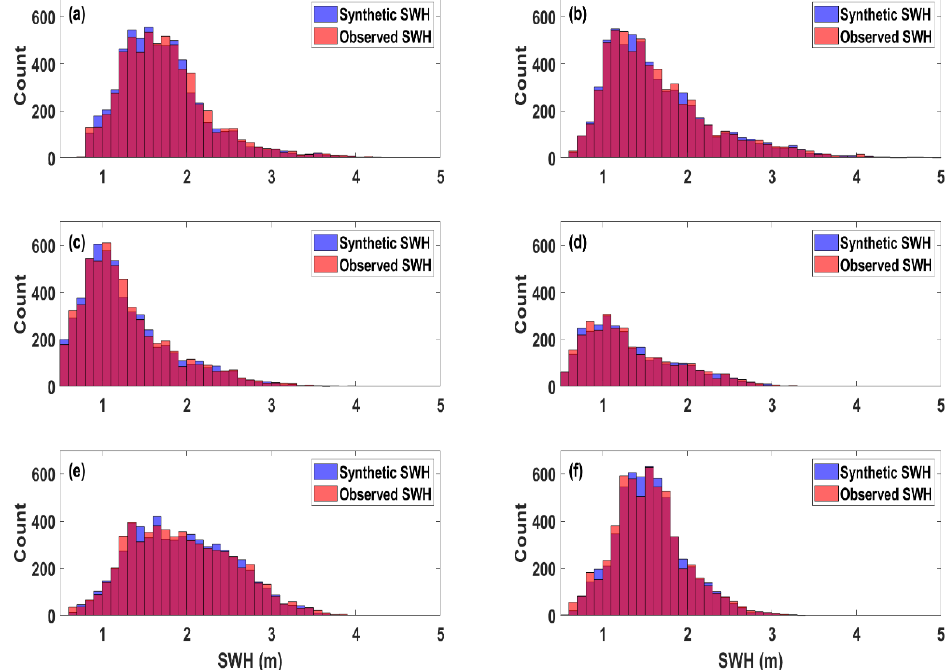
Figure 4. Histograms of synthetic LSTM-generated vs. NDBC-observed significant wave height (m) for buoys ( a ) 42056, ( b ) 42057, ( c ) 42058, ( d ) 42059, ( e ) 41046, and ( f ) 41047. Table 3. Error statistics between LSTM-generated and NDBC observed significant wave height. NDBC ID